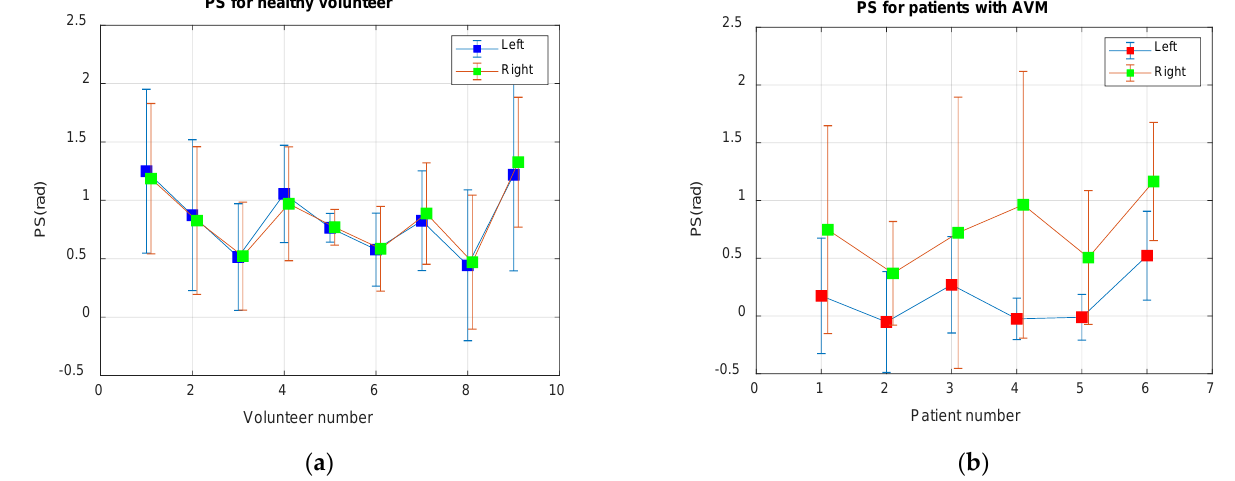
Figure 2. Average phase shift (PS) between the BP and BFV signals in the Mayer waveband: ( a ) For nine healthy volunteers; ( b ) For six patients with an AVM in the area of the left middle cerebral artery.